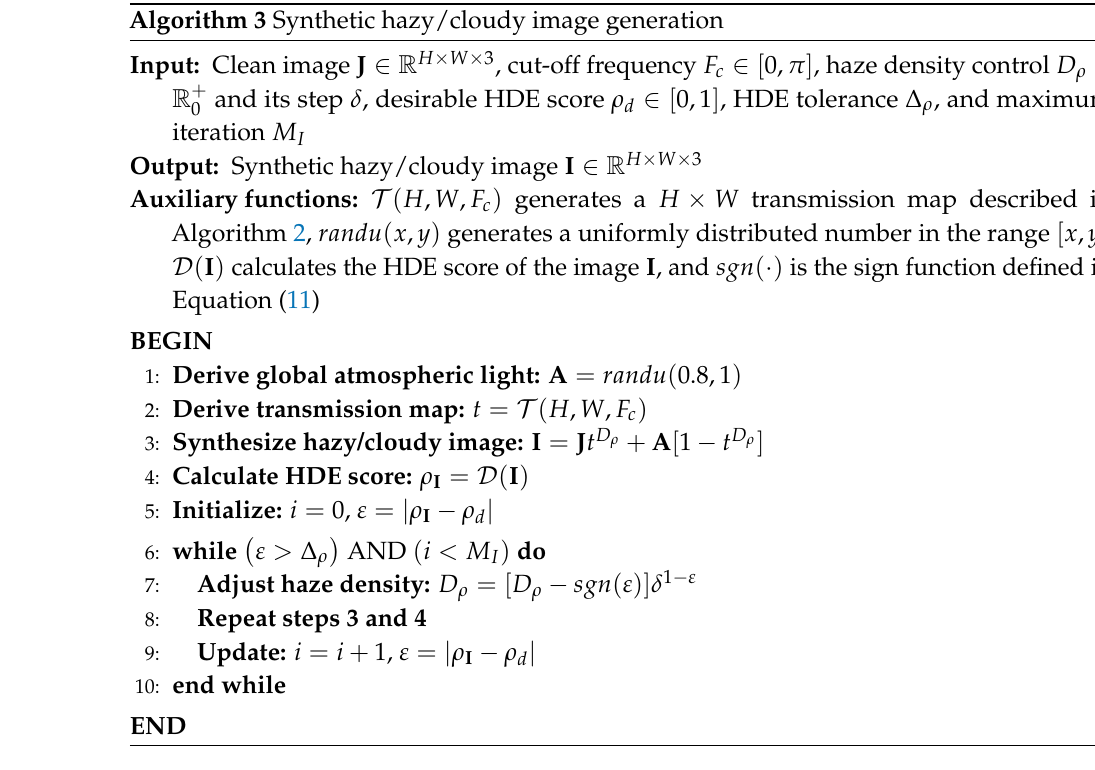
Table 8. Summary of detection results for a YOLOv4-based high-level object recognition algorithm operating on images in Figure 9. The symbol # denotes